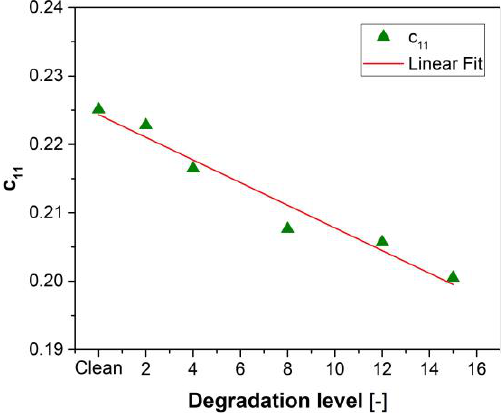
Figure 6. Coefficient b 11 computed from linearization for different levels of compressor degradation (dots) and the linear fit curve.